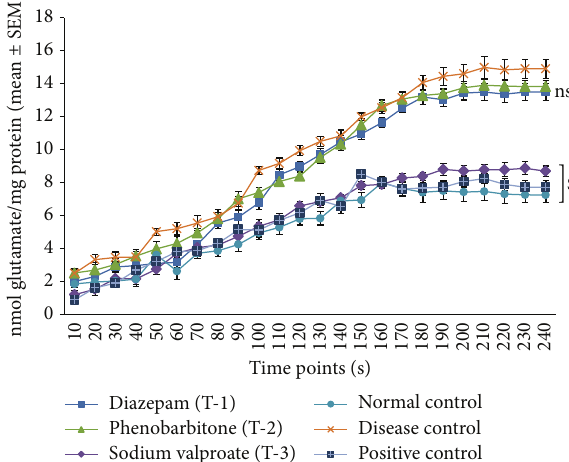
Figure 2: Glutamate released from the synaptosomes at different time points detected fluorimetrically. Diazepam and phenobarbi- tone did not show any inhibition in the glutamate release. Glutamate release from the synaptosomes of the animals of sodium valproate group (T-3) group was significantly lower than the diseased control group [ 𝑛 = 6 ], [ ∗ 𝑃 ≤ 0.05 by one way ANOVA (Dunnett’s multiple comparisons test)]. ∗ indicates that the observed neuro- logical/clinical signs of EAE in animals of T-2 and T-3 group were significantly different ( 𝑃 ≤ 0.05 ) from that of disease control